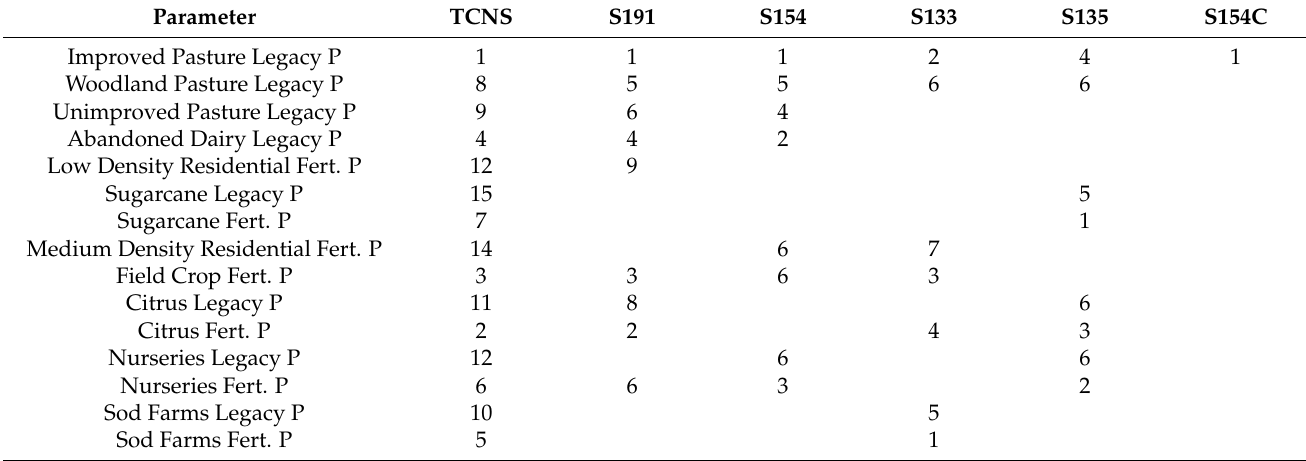
Table 3. Summary of parameter importance ranks 1 identified from the Morris method Global Sensitivity